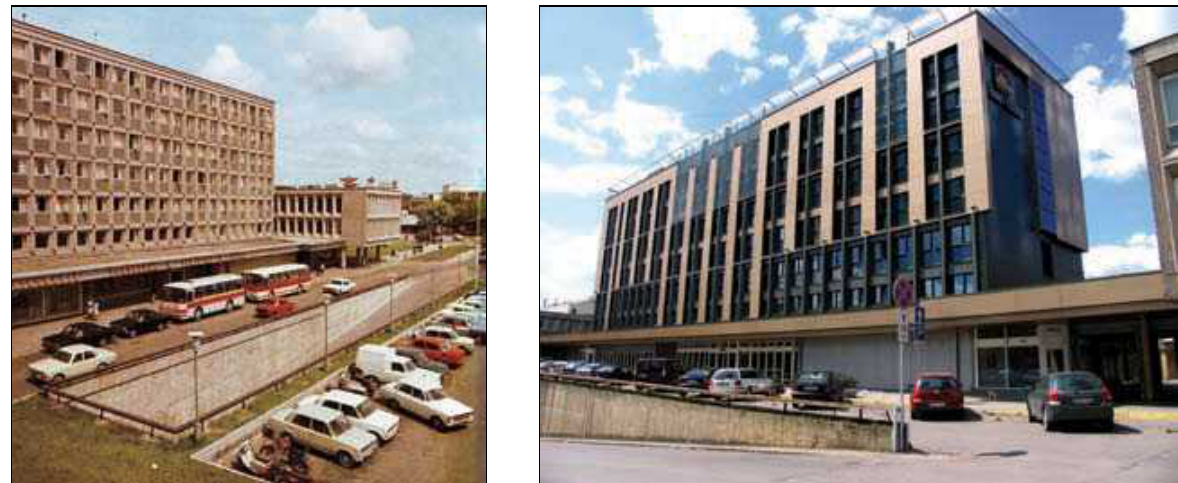
7, 8 pav. Viešbu­tis „tu­ristas“ Vilniu­je (arch. J. Šeibokas) 1978 m. ir dabar (7 pav. paimtas iš katalogo Vilnius . Vilniu­s: Mintis, 1980; 8 pav. nu­otrau­ka au­torės) Figs. 7, 8. hotel “tu­ristas” in Vilniu­s (arch. J. Šeibokas) in 1978 and